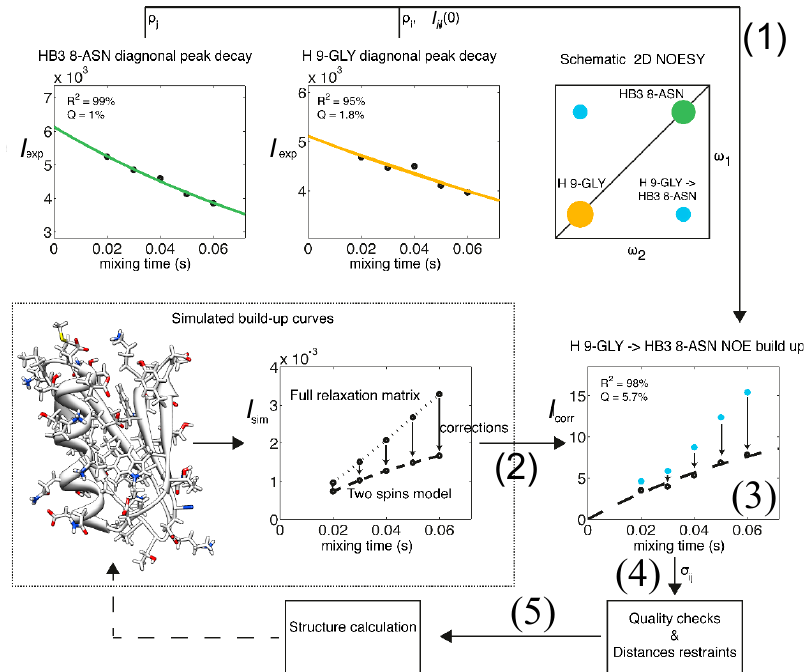
Figure 2. Flow chart representation of the eNORA structure determination protocol using eNOEs. As an example, the eNOE originating from the amide H of Gly9 (spin i , orange) and enhancing H β 3 of Asn8 (spin j , green) of GB3 is shown. (1) The diagonal-peak intensities derived from the NOESY spectra are fitted to mono-exponential decay functions to extract the auto-relaxation rate constants ρ i and ρ j , and the initial magnetizations, ∆ M ii (0) and ∆ M jj (0); (2) A build-up curve taking into account all magnetization pathways is simulated with the full relaxation matrix approach. This simulation requires a 3D structure as input, which may be based on a conventionally determined structure with sufficient accuracy; (3) Corrections for the intensities at each mixing time are applied to the experimental NOE build-ups; (4) The NOE build-up intensity is fitted, the quality of the fit is evaluated, and upper- and lower-bound distance restraints are created; (5) A structure calculation is performed with the new distance restraints using established packages such as CYANA [39,40]. This structure may be used as an input for (2) in a new cycle, as indicated by the broken arrow. Adapted from [38] with permission from ACS, Copyright